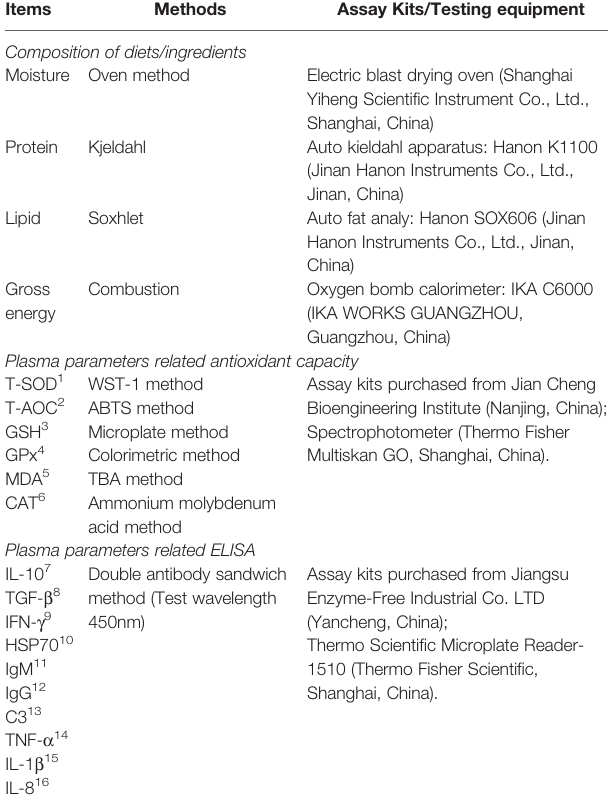
TABLE 2 | The chemical analysis used in the